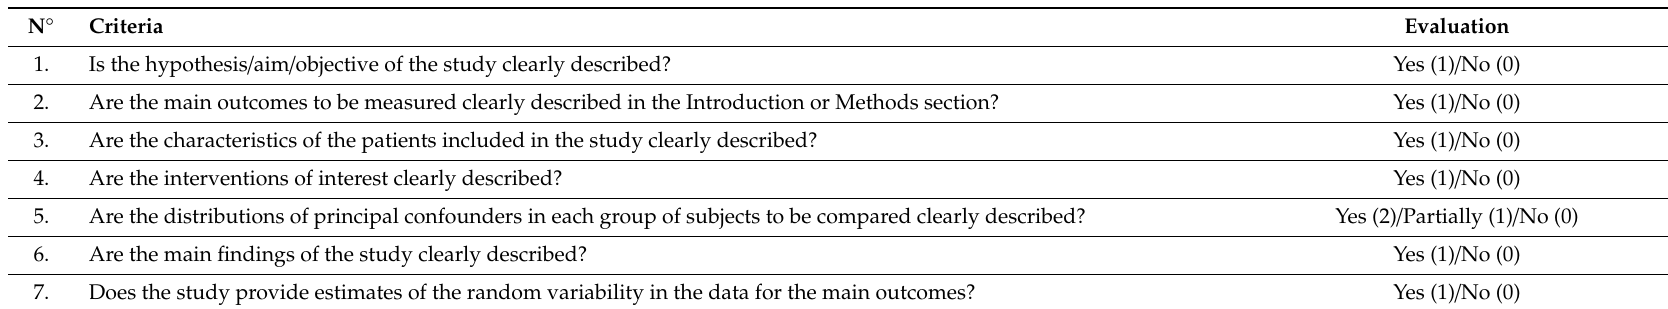
Table A6. MD & B-checklist adapted from “The feasibility of creating a checklist for the assessment of the methodological quality both of randomized and non-randomized studies of health care interventions”